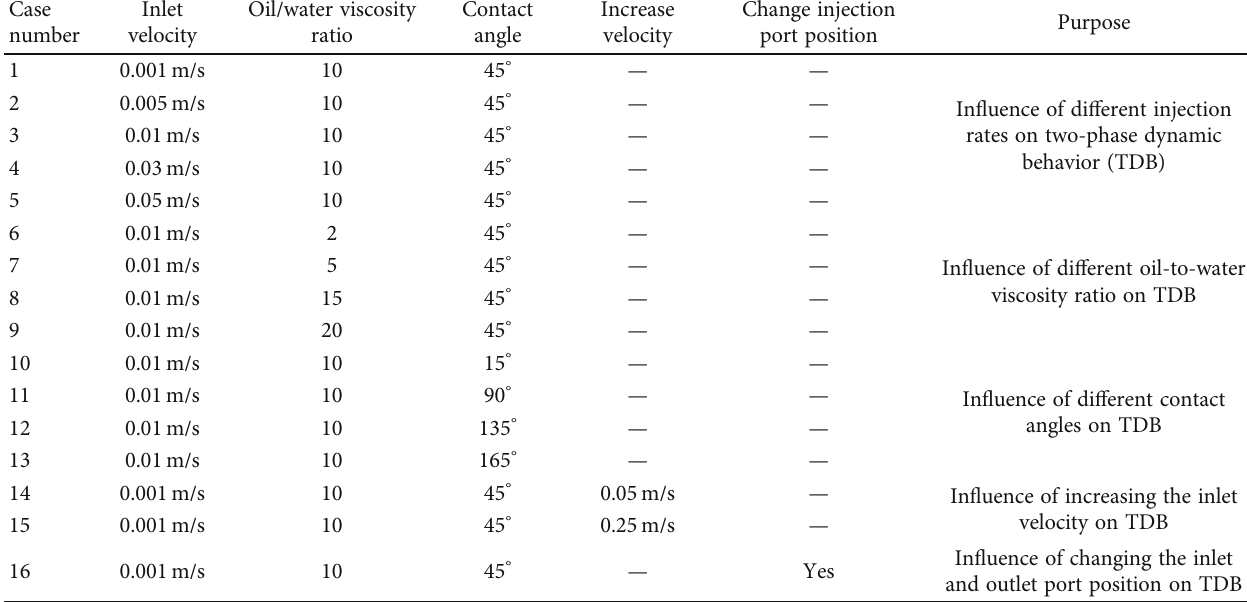
Table 1: Case settings.